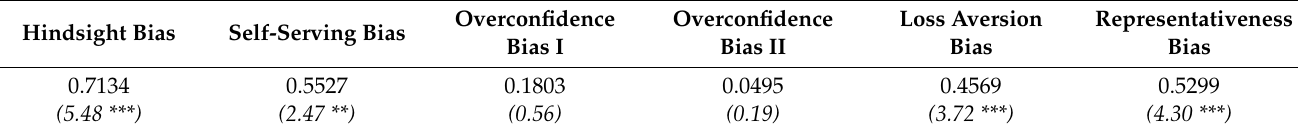
Table 3. Regression